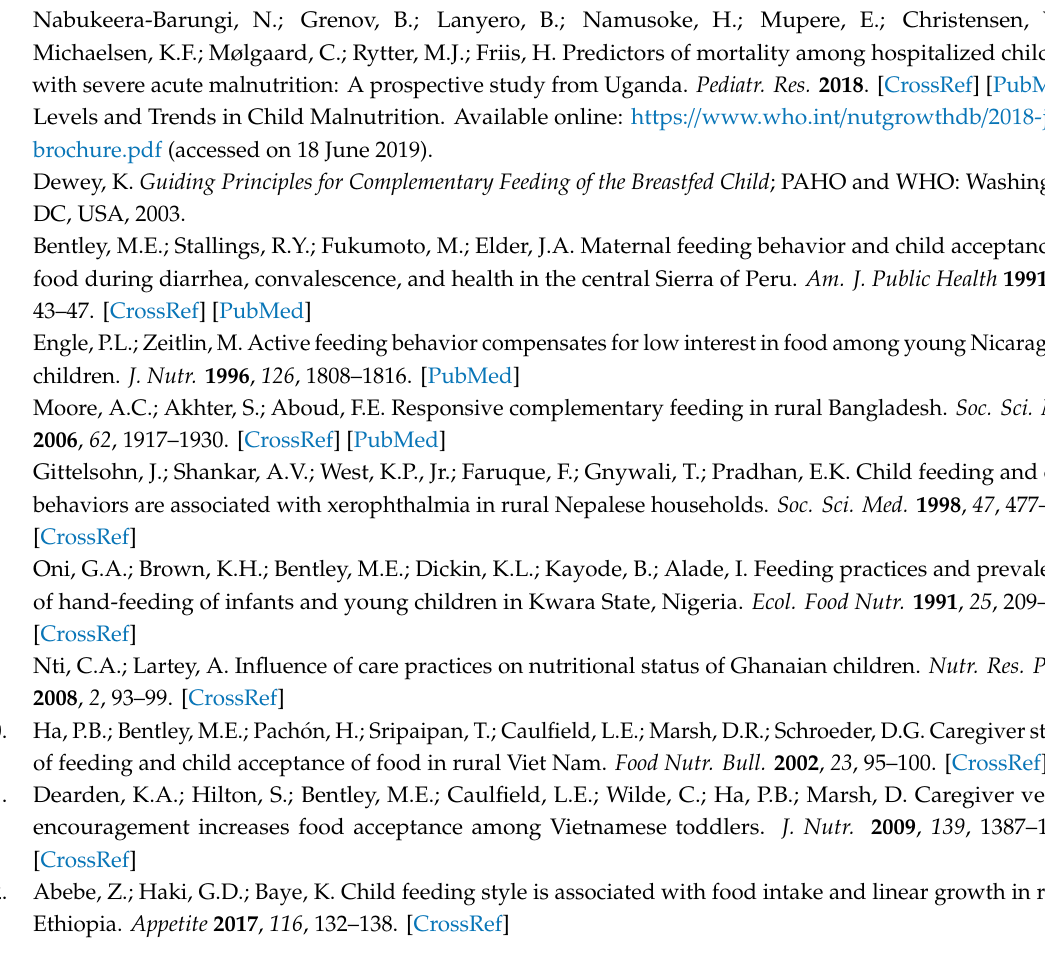
Figure S1: (a) Child interest in food (b) Child mood (c) Child distraction, by meal stage and nutritional status’ UN: Undernourished; Figure S2: (a) Caregiver encouragement (b) Caregiver negative actions (c) Caregiver